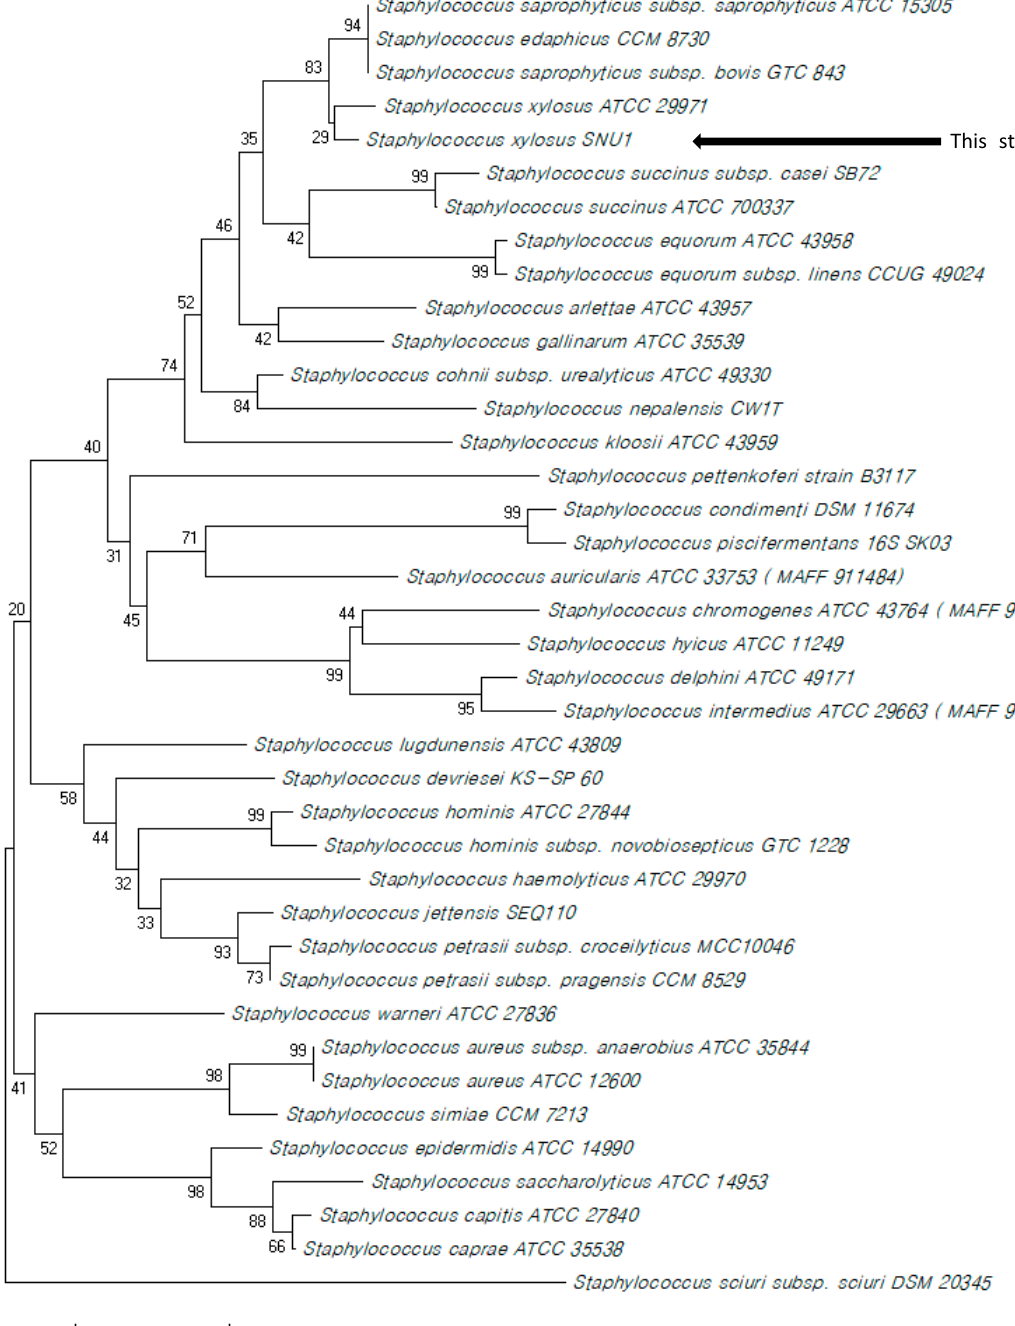
Figure 3. Phylogenetic tree constructed using partial 16S rRNA gene (1458 bp) of Staphylococcus spp. using the neighbor-joining method, bootstrap 1000, of MEGA 10.0 (GenBank accession number: MN294563).